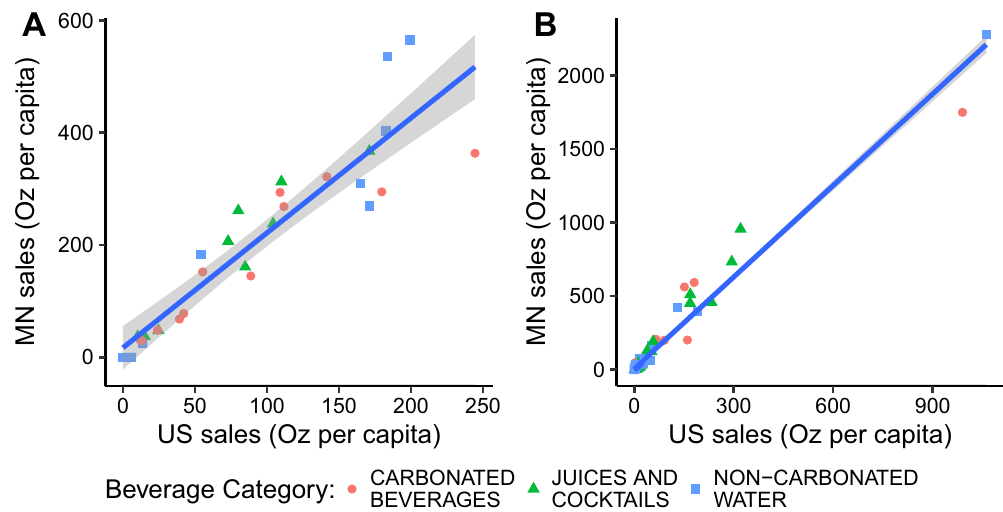
Figure 4. Sales per capita in Minnesota and the entire U.S. for all focal brands ( A , n = 30) and for all size-category combinations available in Minnesota ( B , n = 204). The blue line represents the best linear approximation and the gray envelope its standard